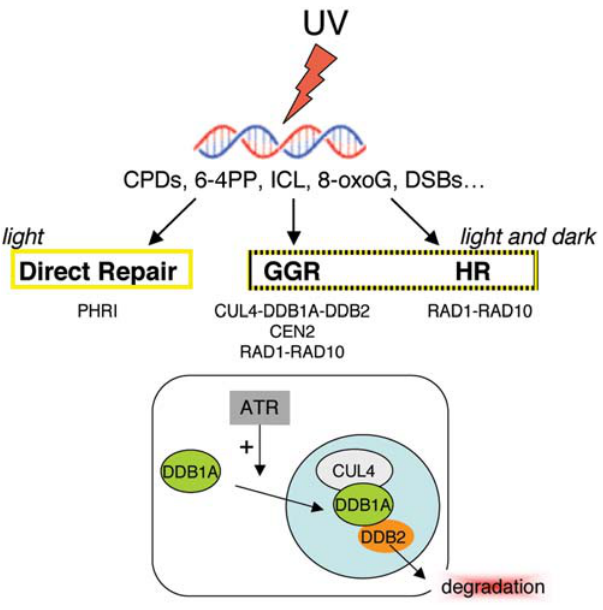
Figure 7. Schematic representation of DNA repair pathways in plant cells and control of DDB2 stability upon UV exposure.